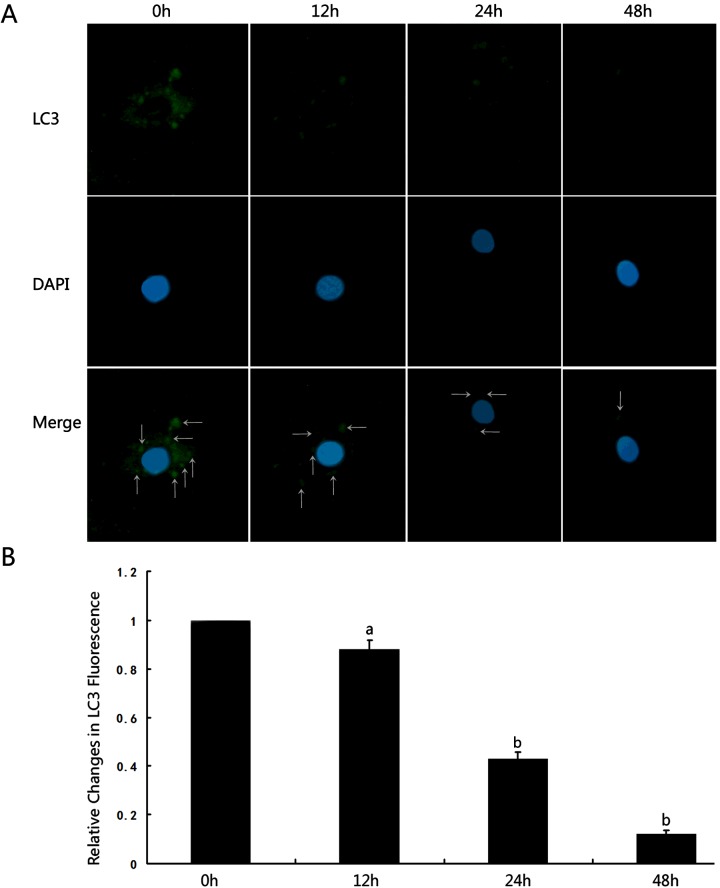
Mechanical stress inhibited autophagy in human podocytes(A) LC3-II immunostaining in podocytes under mechanical stress was performed at 0 h, 12 h, 24 h and 48 h visualized by confocal photomicrographs (×1200). (B) The representative LC3-II punctate dots quantification was shown along with statistical bar graph analysed by Image Pro Plus software. aP> 0.05 compared with 0 h, bP<0.05 compared with 0 h (n=6).